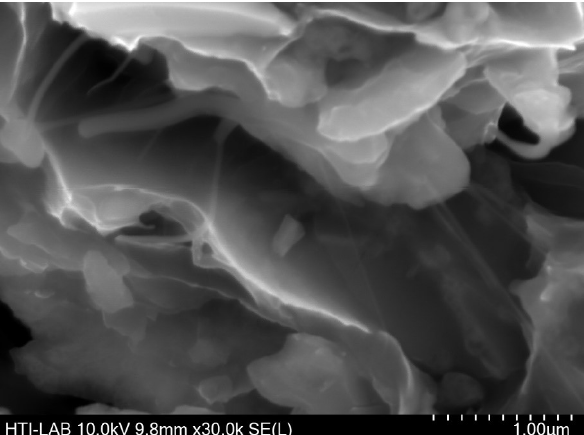
Figure 2: FESEM image shows the MWCNT acts as bridges between the grains from the fractured surface after the tensile test.